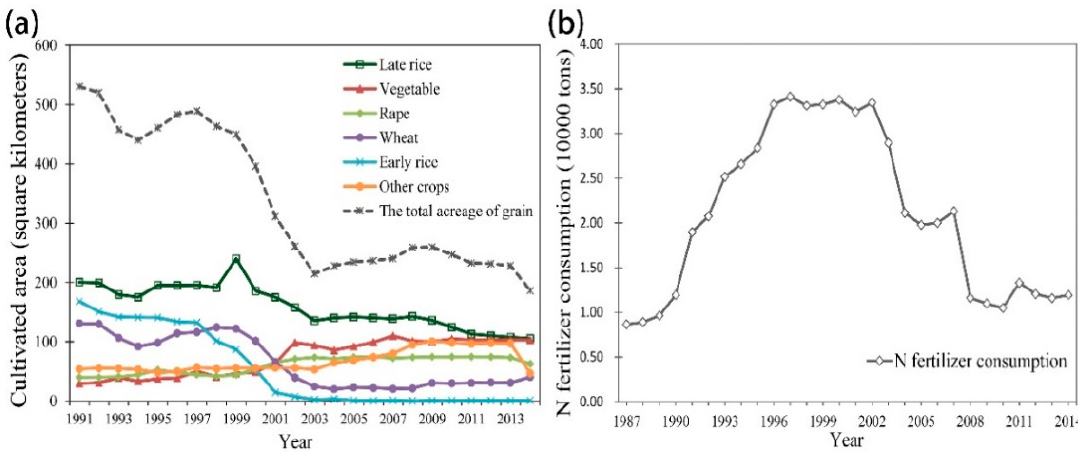
Figure 9. The crop planting structure in Fuyang District from the 1990s to the 2010s ( a ) and the content of nitrogen fertilizer consumption in Fuyang District from the 1980s to the 2010s ( b ).